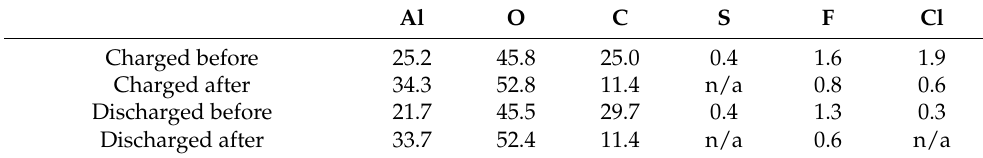
Figure 2. High − resolution X − ray photoelectron spectroscopy (XPS) spectra of the Al anode, in charged and discharged states, before and after the etching step: ( a ) Al 2p, ( b ) O 1s, ( c ) C 1s and ( d ) S 2p. The dashed lines are guides for the eyes. The legends of chemical bonds refer to the regions (outlined in green and purple colored background) where they are commonly found. Table 1. Elemental analysis (at%) of the Al anode (cid:48) s surface, as calculated from XPS